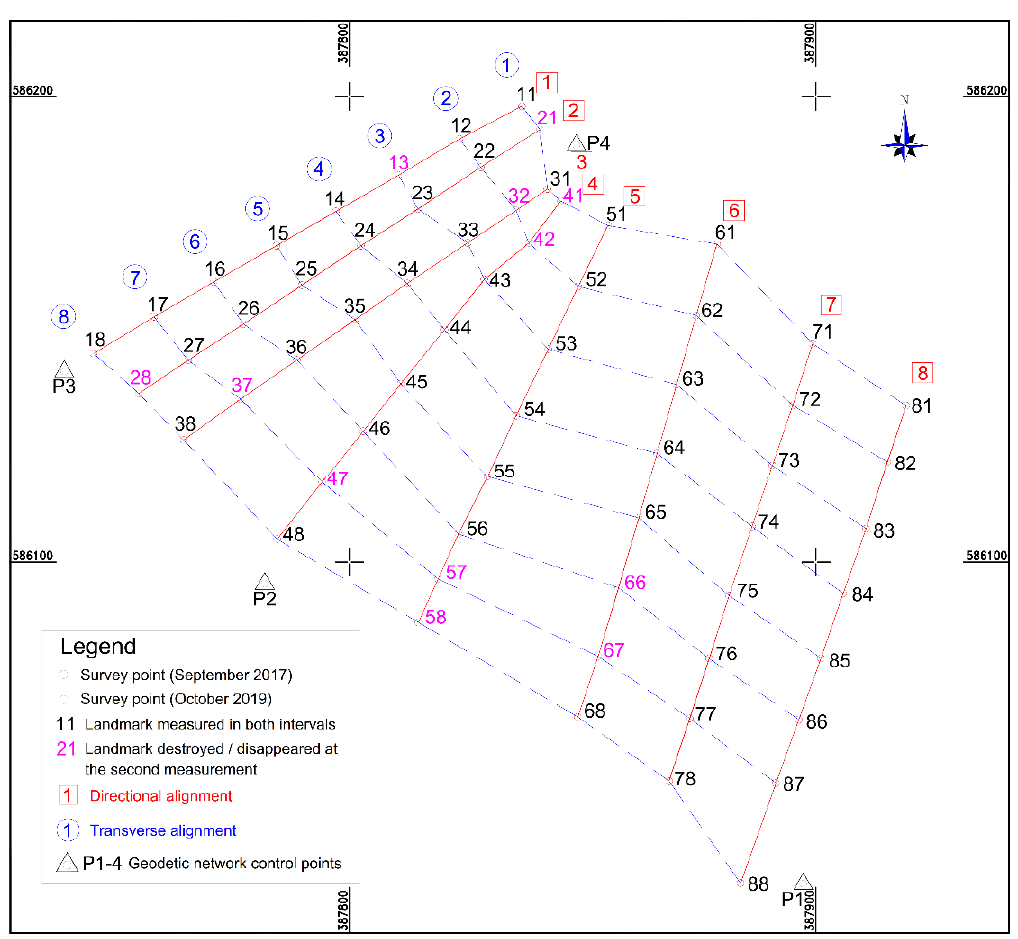
Figure 9. Surveyed landmarks and landslide directional alignments.